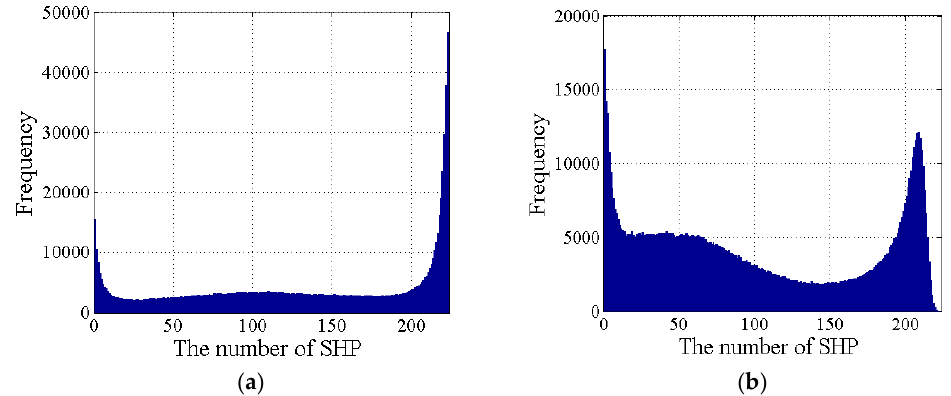
Figure 16. Histograms of the SHP number identified by ( a ) KS test and ( b ) FaSHPS. Horizontal axis is the number of SHPs based on a 15 × 15 window. Vertical axis is the pixel count at each corresponding SHP number.